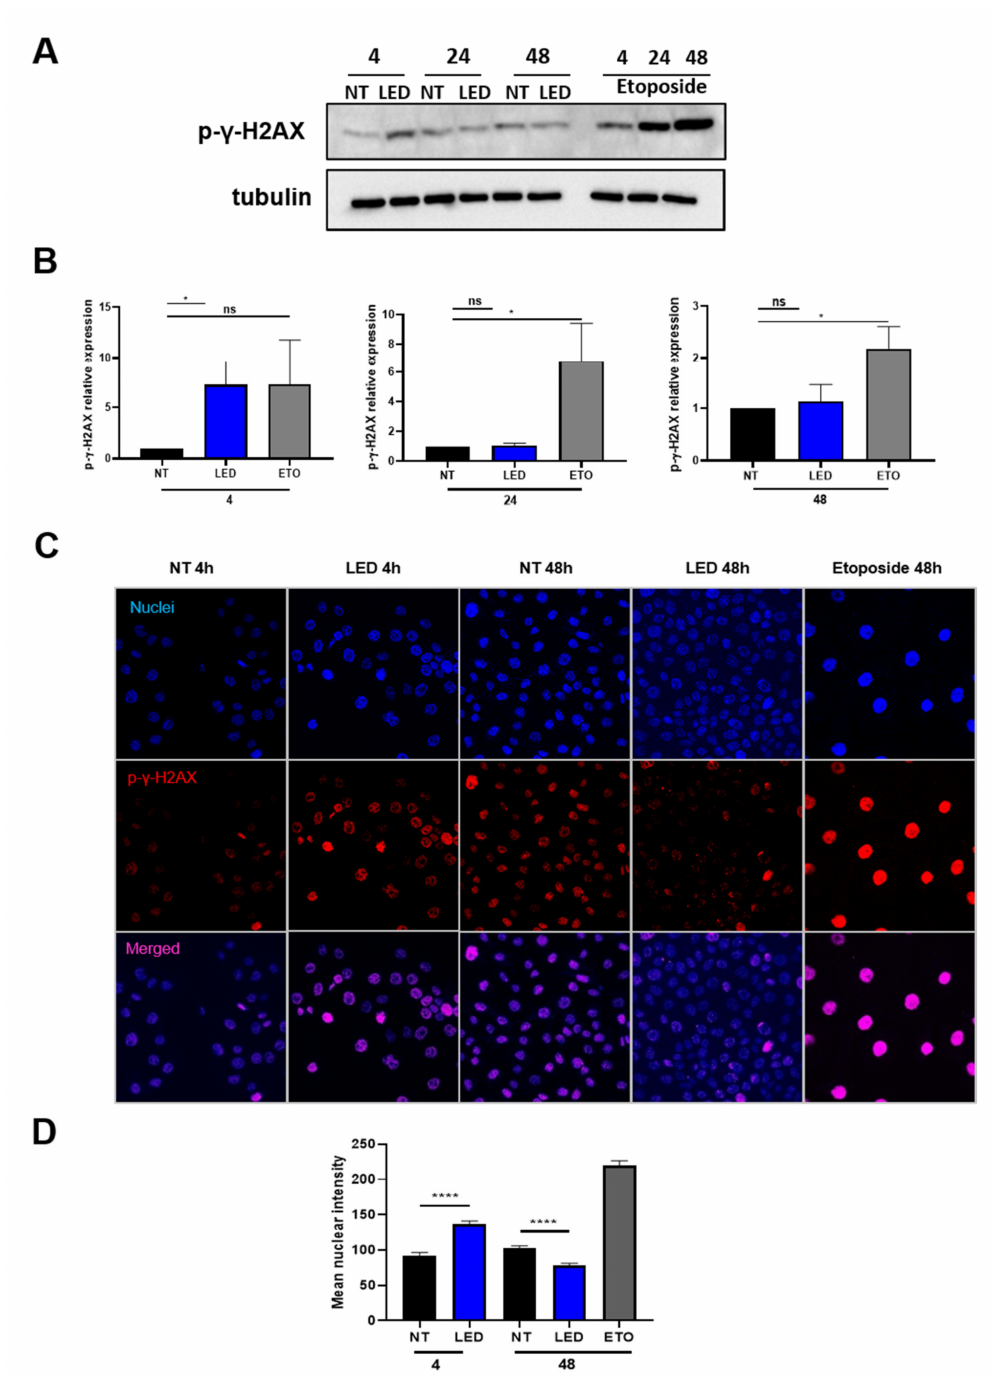
Figure 3. Exposure to b-LED causes a transient induction of γ -H2AX histone in HaCaT cells. ( A ) WB showing the expression of γ -H2AX histone (phospho S139) in HaCaT cells exposed to b- LED for 4 h and then analyzed at the indicated times. Etoposide (10 µ M) was used as positive control. Western blot analysis was performed on total lysates. Tubulin was detected as a loading control. ( B ) Densitometric quantification of the experiment shown above. Results are expressed in terms of fold change. ( C ) Confocal immunofluorescence showing the expression of γ -H2AX histone (phospho S139) in cells stimulated as in ( A ). ( D ) quantification of the experiment shown in ( C ). At least 120 nuclei were quantified from 2 independent experiments. Bars represent the mean ± SEM of duplicate determinations in four independent experiments. * p < 0.05, **** p < 0.0001 and ns, not